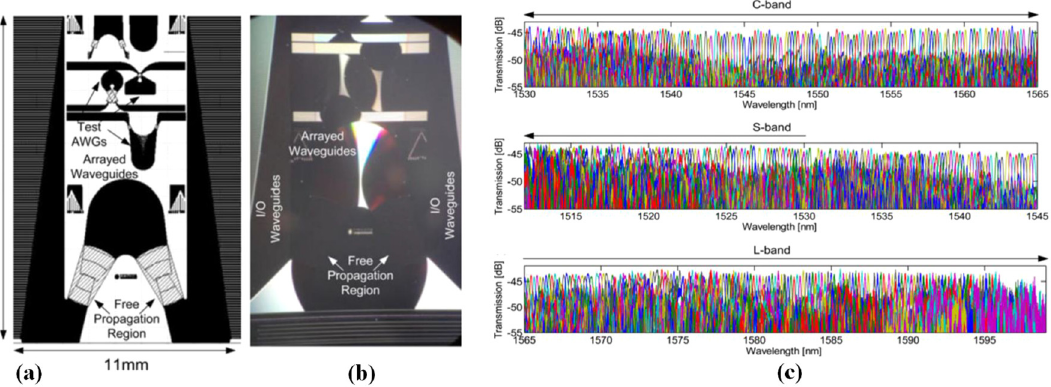
Figure 16: (a) Layout of 512 × 512 25-GHz AWG. (b) Image of the fabricated device on the SOI platform. (c) Measured spectrum across the 512 channels, covering S , C , and L bands [213]. AWG, arrayed waveguide grating; SOI, silicon-on-insulator.